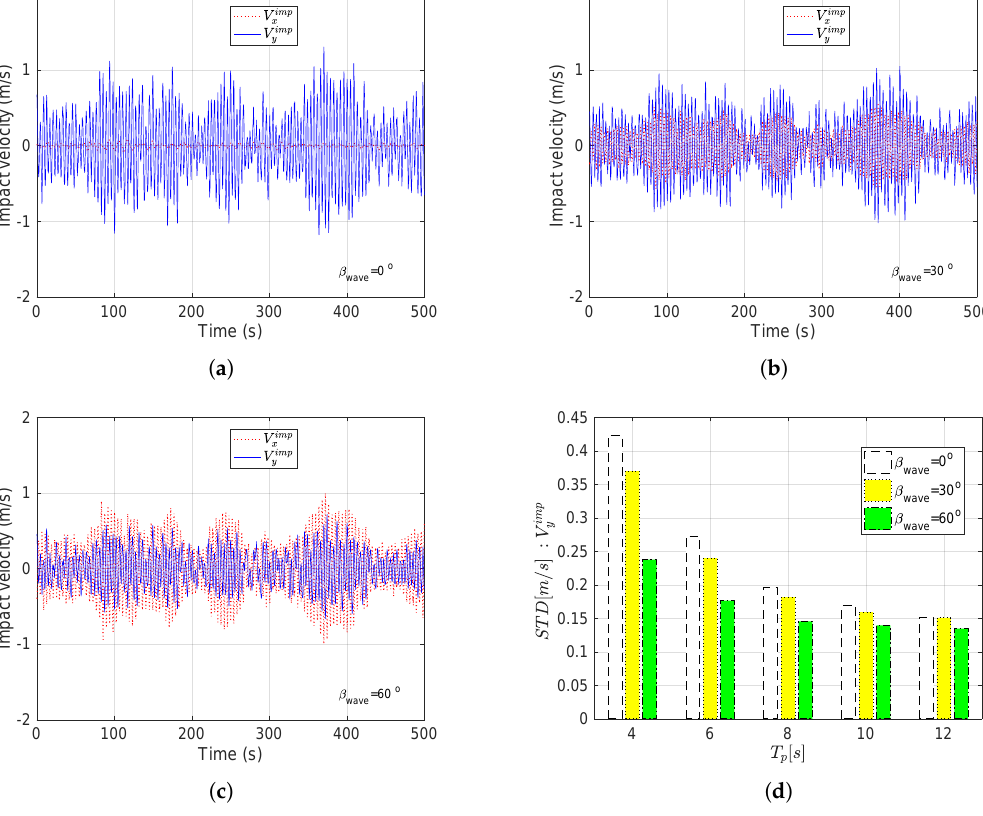
Figure 10. Response-time histories for V imp x and V imp y for load case H s = 2 m, T p = 4 s, U w = 8 m/s and for different wind–wave misalignment ( a ) β wave = 0° ( b ) β wave = 30° ( c ) β wave = 60° ( d ) comparison of standard deviations for V imp y for different T p = 4 s, 6 s, 8 s, 10 s, and 12 s.